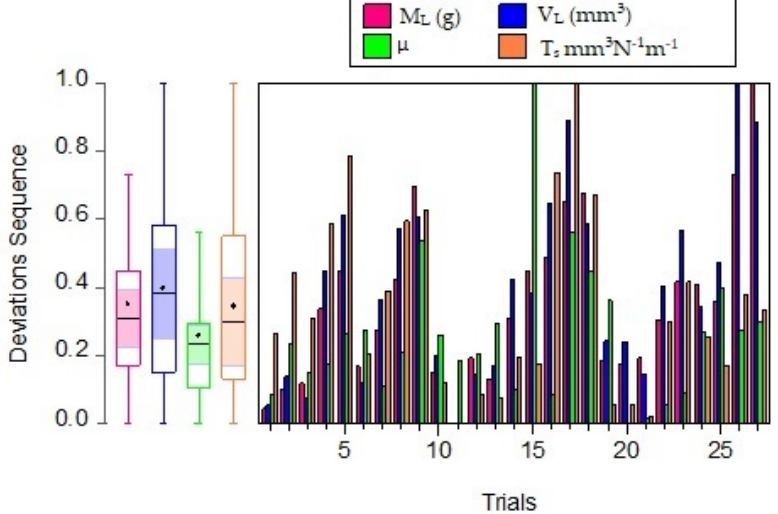
4 ) hybrid Taguchi–OA. T 27 (3